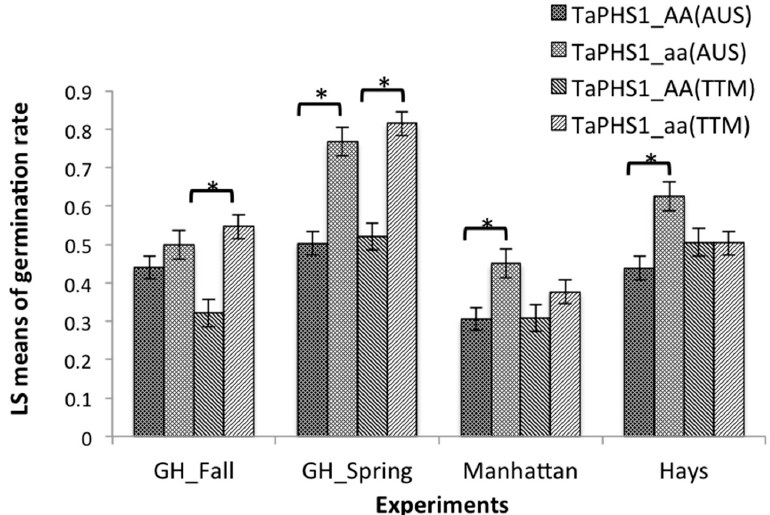
Figure 1. Effects of TaPHS1 gene from AUS1408 and Tutoumai A on germination rates evaluated in the 2015 fall and 2016 spring greenhouse experiments (GH_Fall and GH_Spring) and in the 2016 Manhattan and Hays, KS, field experiments. * Significant differences between least square means of germination rate at p < 0.05.